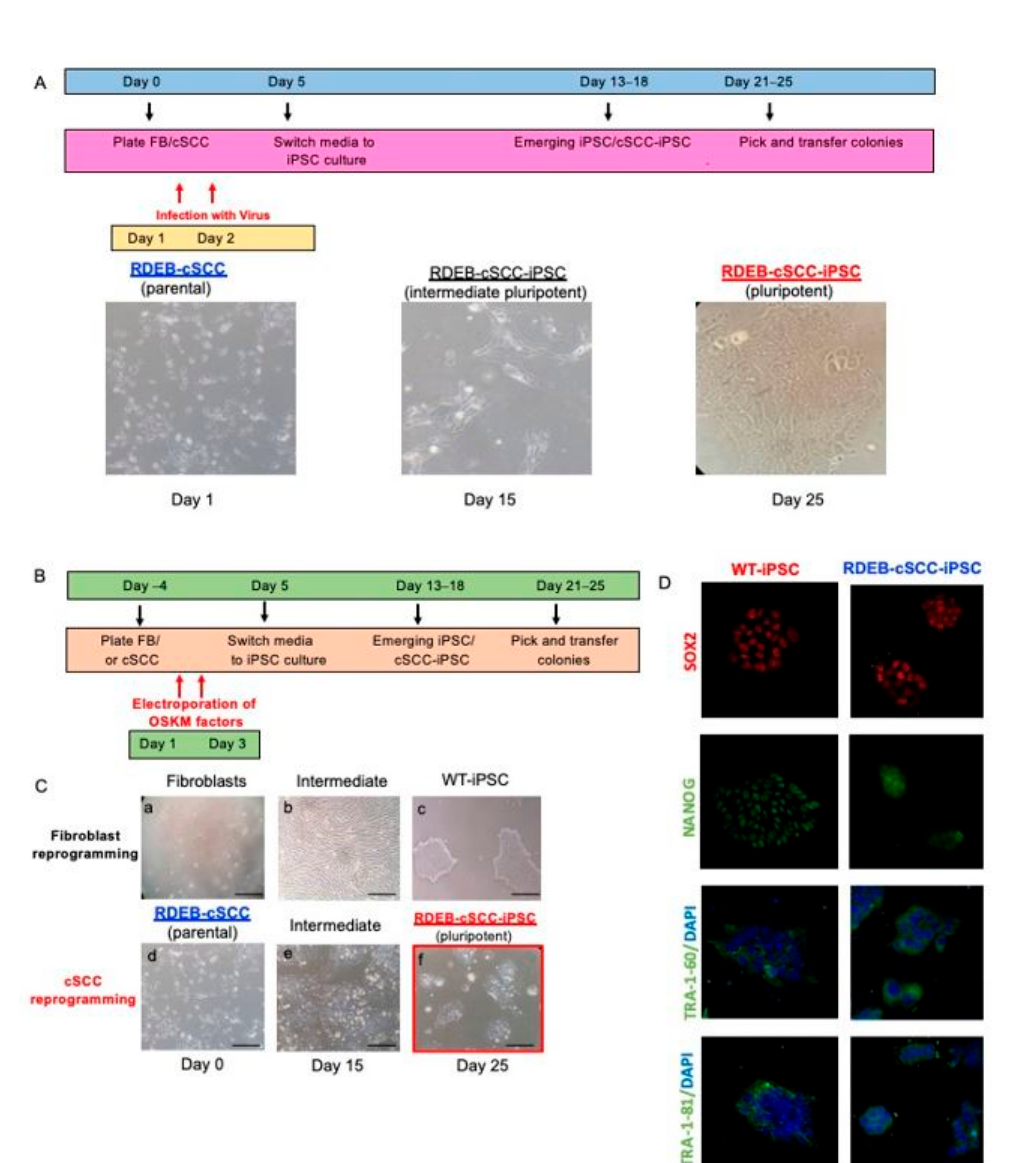
Figure 1. Reprogramming and characterization of reprogrammed RDEB-cSCC cells. ( A ) Timeline for lentivirus-based method to reprogram RDEB-cSCC into RDEB-cSCC-iPSC. Representative pictures taken throughout the reprogramming method are also shown. ( B ) Timeline for feeder-free method to reprogram RDEB-cSCC into RDEB-cSCC-iPSC using an episomal plasmid. ( C ) Morphology of RDEB-cSCC-iPSC derived from RDEB-cSCC compared to WT-iPSC derived from fibroblasts. iPSCs appear to be morphologically similar (small cell shape, large nuclear-to-cytoplasmic ratio, prominent nucleoli, tight and flat colonies). ( D ) Immunofluorescence staining of stem cells markers in WT-iPSCs and RDEB-cSCC-iPSCs.